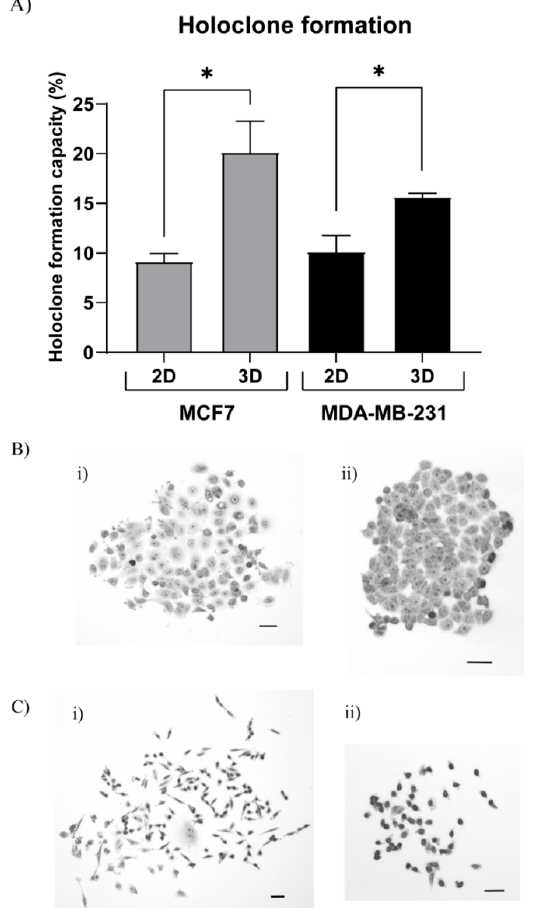
Figure 6. 3D TEMPO-CNF environments increase holoclone formation properties. MCF7 and MDA- MB-231 cells were cultured in 3DPS and 2D for 2 weeks or 48 h, respectively, detached and analyzed for holoclone formation properties. ( A ) The holoclone formation ability was quantified for MCF7 and MDA-MB-231 cells grown in 3D TEMPO-CNF scaffolds compared with 2D culture. Unpaired t -test: Gaussian distribution between 2D and 3D within each cell line. Average ± standard error of the mean, * p -value < 0.05, n = 9. Holoclone formation assay with ( B ) MCF7 and ( C ) MDA-MB-231 cells grown in 3D TEMPO-CNF scaffolds. Images illustrates differentiated cells ( B ( i ), C ( i )) and holo- clones ( B ( ii ), C ( ii )). Scale bars 50 μ m.